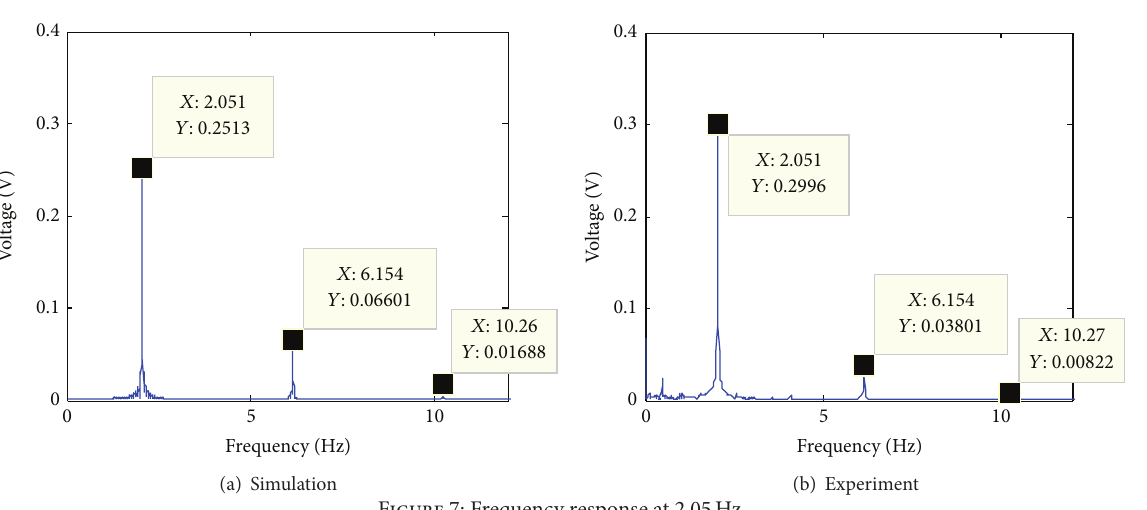
Figure 7: Frequency response at 2.05